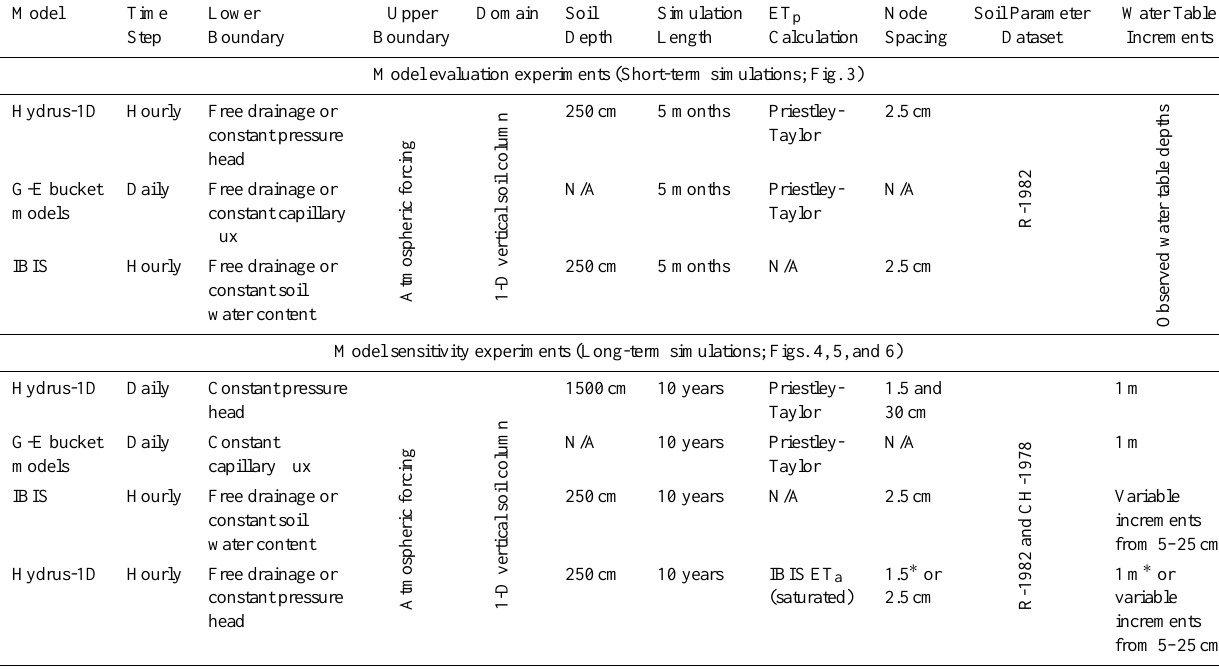
Table 3. Model characteristics, boundary conditions, and experimental design for the model-observation evaluation period (i.e., short-term simulations) and the model sensitivity experiments (i.e., long-term simulations). See Sect. 3 for further details.